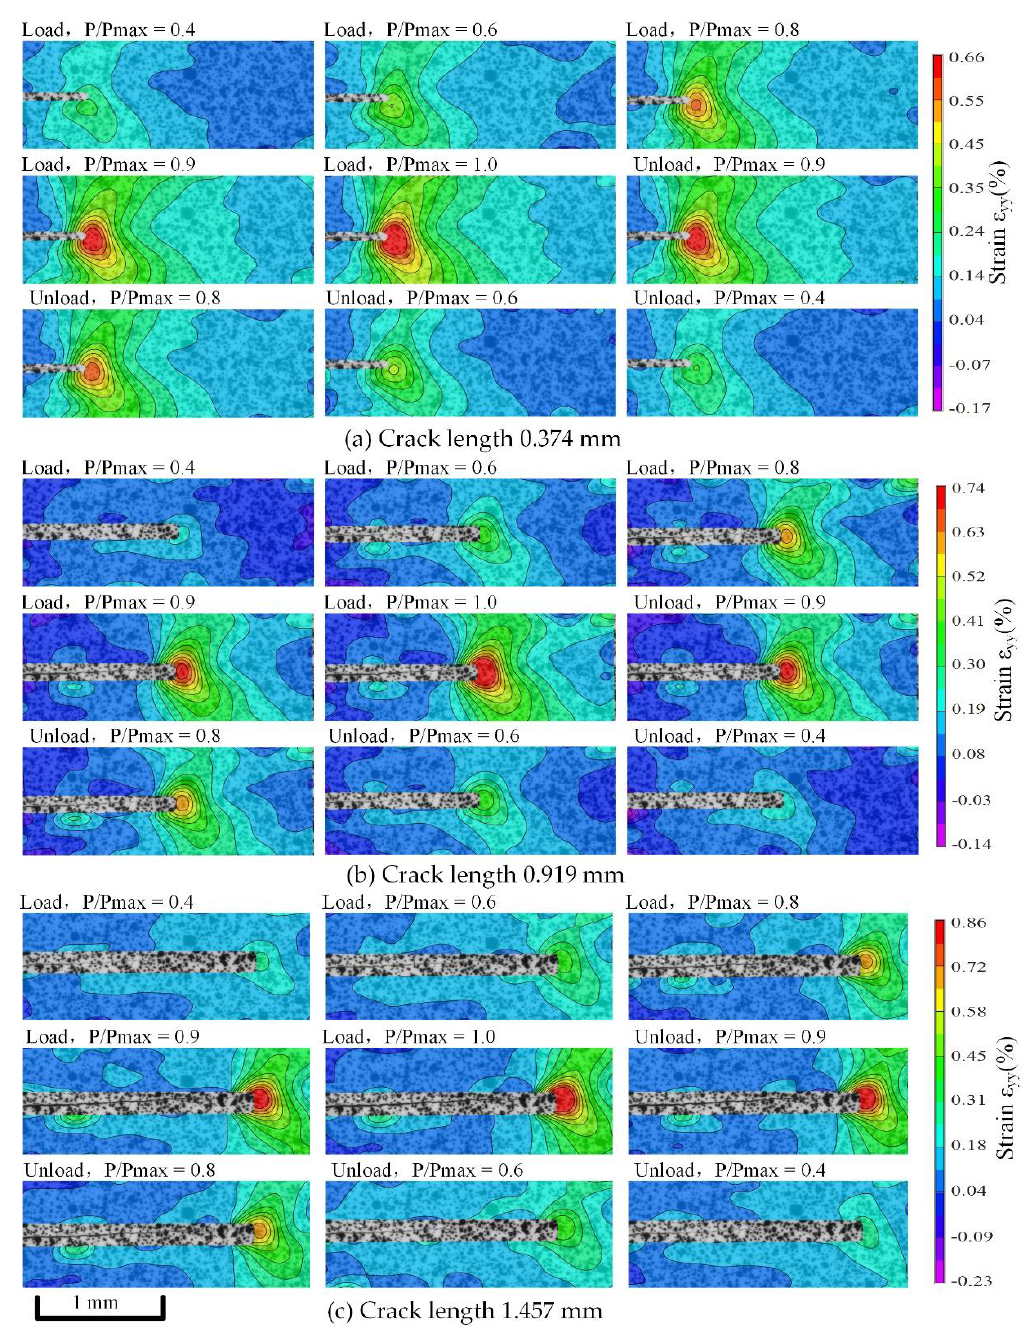
Figure 13. Strain fields ’ evolution during crack closure with stress ratios of 0.2.